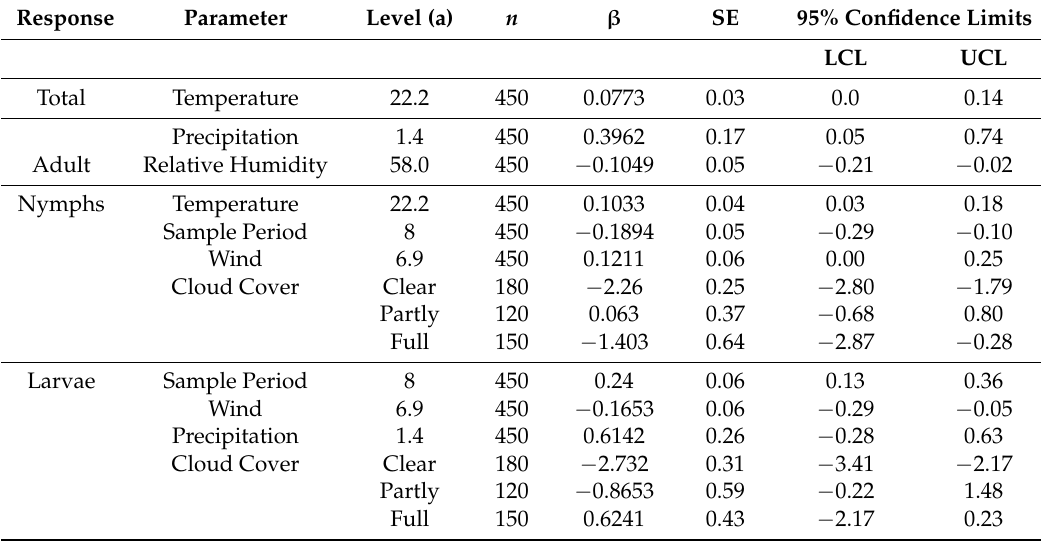
Table 5. Coefficient ( β ), standard error (SE) and 95% confidence limits of significant weather variables on presence of Amblyomma americanum (L.) collected in